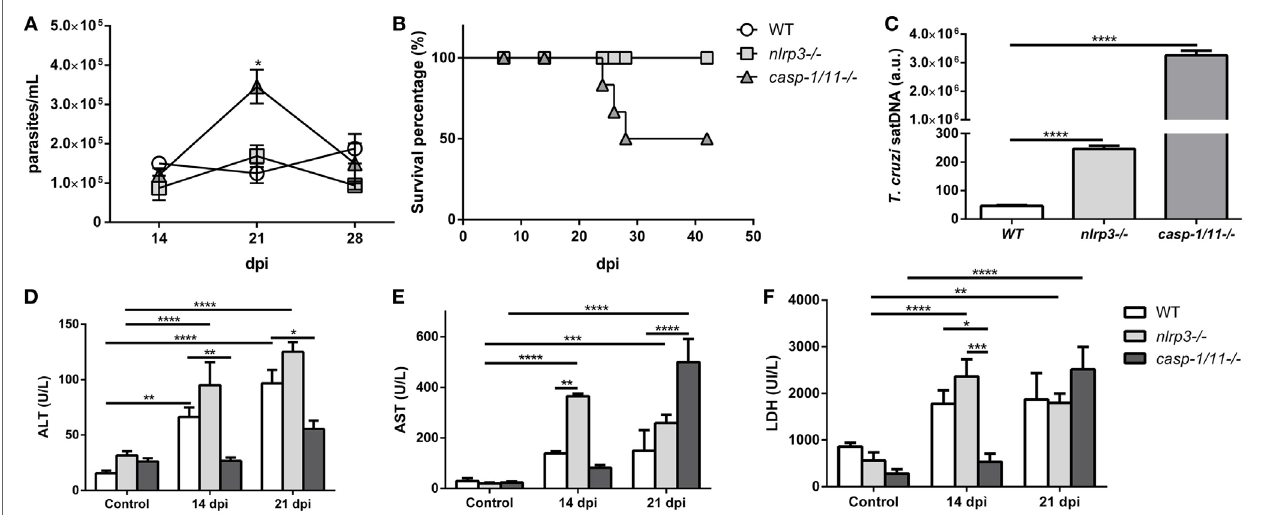
FigUre 6 | Caspase-1/11 signaling is required for controlling Trypanosoma cruzi infection but contributes to liver inflammation. Wild type (WT), nlrp3 − / − , and caspase-1/11 − / − mice were i.p. inoculated with 10 3 trypomastigotes-Tulahuen strain. (a) Parasitemia levels were examined microscopically at the indicated time points. (B) Survival percentages from infected WT and KO mice up to 42 days post infection (dpi). (c) Hepatic parasitic load was determined by qPCR of satDNA of T. cruzi relative to TaqMan endogenous control and expressed as arbitrary units (a.u.) from infected WT, nlrp3 − / − , and caspase-1/11 − / − mice at 21 dpi. Activity levels of (D) ALT, (e) AST transaminases, and (F) LDH in plasma are obtained at 14 and 21 dpi. Data are shown as mean ± SEM from one of three representative experiments; n = 3–6 mice per group. Statistical significance was evaluated by two-way ANOVA followed by Bonferroni post hoc test. * p < 0.05; ** p < 0.01; *** p < 0.001; **** p <